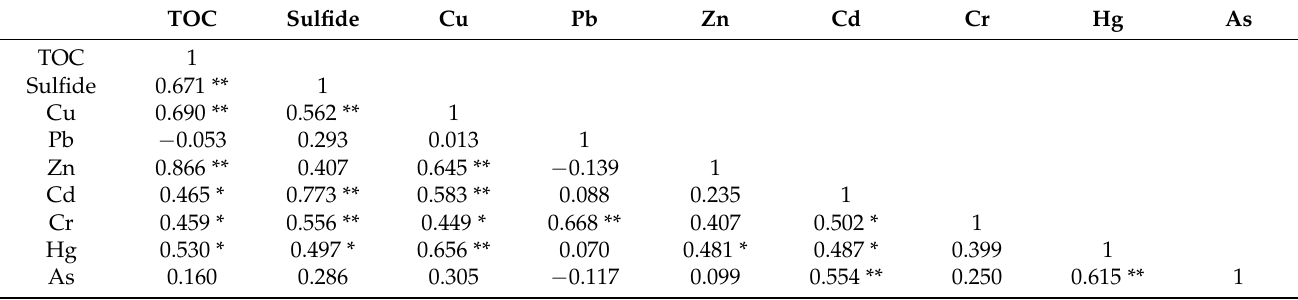
Table 2. Pearson correlation matrix for heavy metals, TOC, and sulfide in the surface sediment of Weitou Bay. TOC